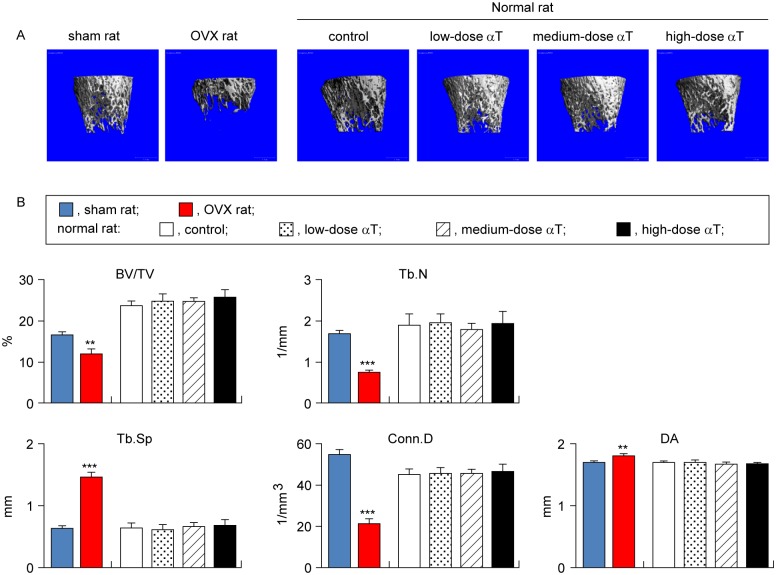
Micro-CT analysis of trabecular bones in distal femur metaphysis.(A) Representative 3-dimensional micro-CT images of trabecular bones in distal femur metaphysis are shown. (B) Microstructural parameters (BV/TV, trabecular bone volume fraction; Tb.N, trabecular number; Tb.SP, trabecular separation; Conn.D, connectivity density; DA, degree of anisotriphy) of trabecular bones in distal femur metaphysis are shown. Data are presented as mean ± standard error of the mean. **P < 0.01, ***P < 0.001 vs. sham rat group.